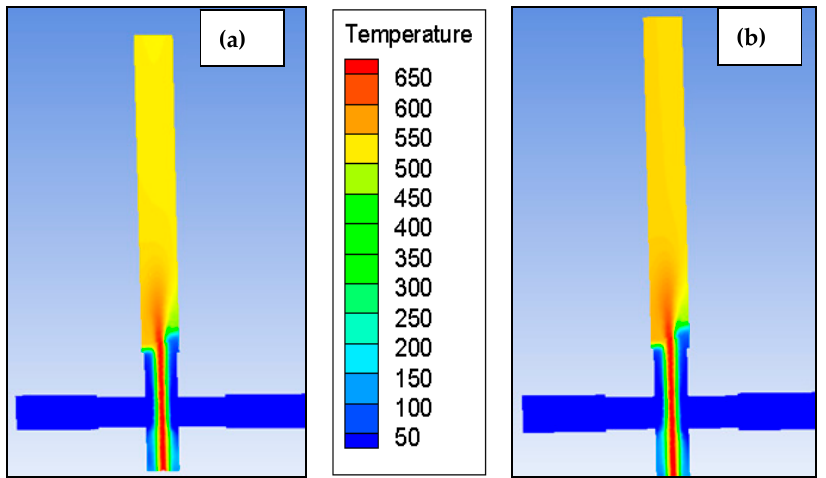
Figure 4. Temperature distribution comparisons obtained at the reactor center face (x = 0, y = 0) where ( a ) using surface growth only model for crystallization and ( b ) using combined aggregation and surface growth model, respectively.